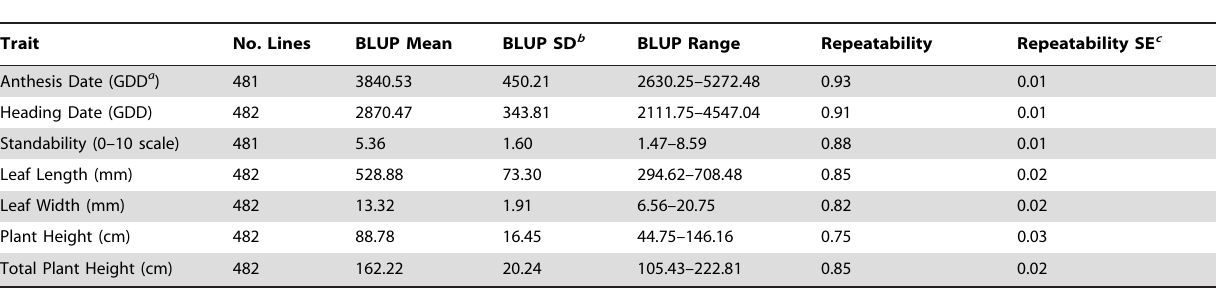
Table 2. Means and ranges for best linear unbiased predictors (BLUPs) of seven morphological traits evaluated on a switchgrass association panel, and estimated repeatability on a clone-mean basis in three summer environments, in Ithaca, NY across three